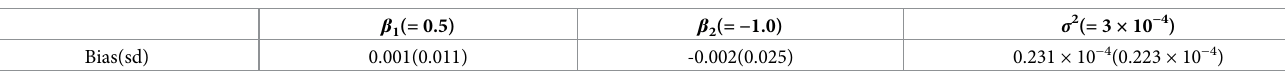
Table 4. Bias (sd) of parameter estimates for the multi-covariate example.